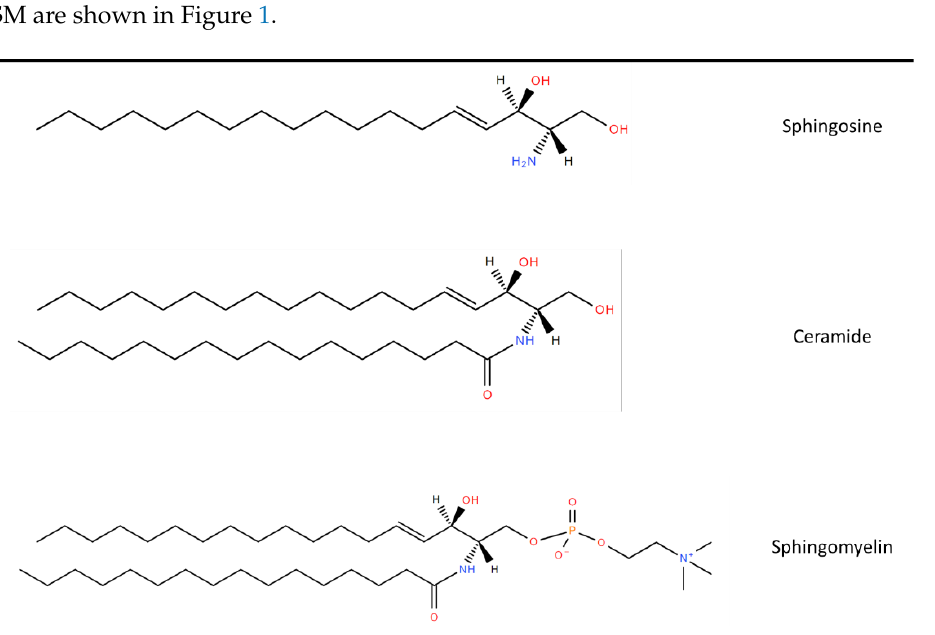
Figure 1. Chemical structure of common Sphingolipids. Sphingosine is the most common long-chain base. A fatty acid acyl chain is connected to the C2 amide group to form Ceramide and then Sphingomyelin is formed by the subsequent addition of a phosphocholine head group. Lipid structures created using LIPID MAPS ® tools [43].